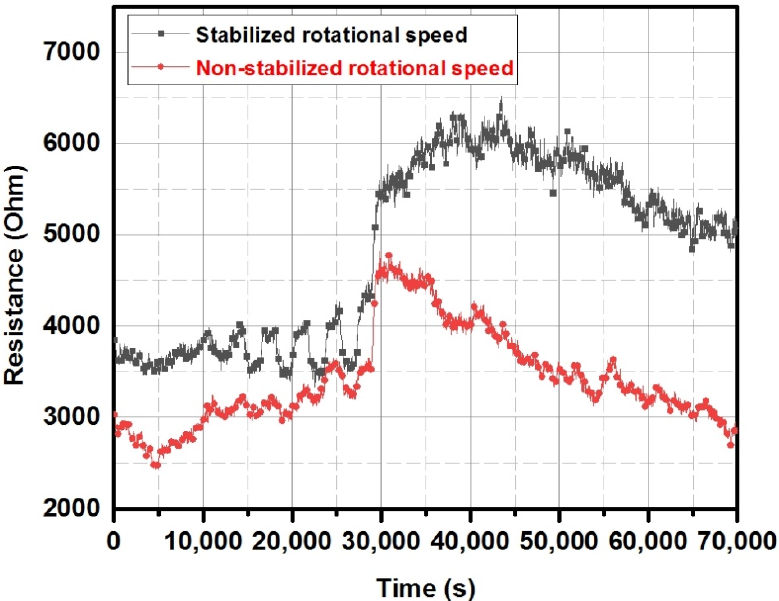
Figure 11. The sensor layers obtained in stabilised rpm conditions (black trace) and not-stabilised (red trace) exposed to variable NO 2 concentrations and atmospheric air.